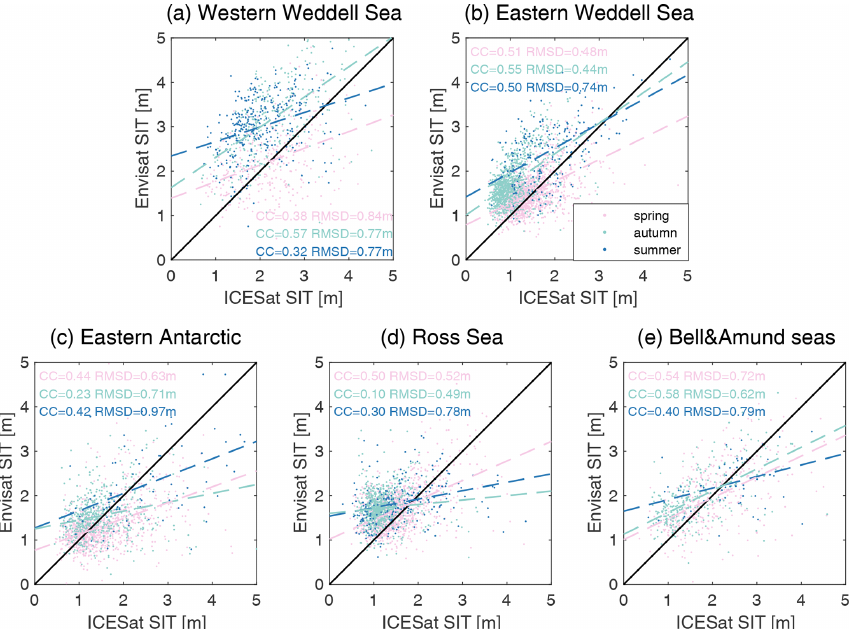
Figure 9. Scatterplots of the individual data pairs between Envisat SIT and ICESat SIT for each region and each season. The data are taken from all seasons available. Since the comparison pairs are too few in the Indian Ocean and western Pacific Ocean, we combine these two regions into the East Antarctic. The respective correlation coefficients and RMSDs are indicated in the panels. The black line is the 1-to-1 fit line, and the dashed colored lines stand for linear regression lines.